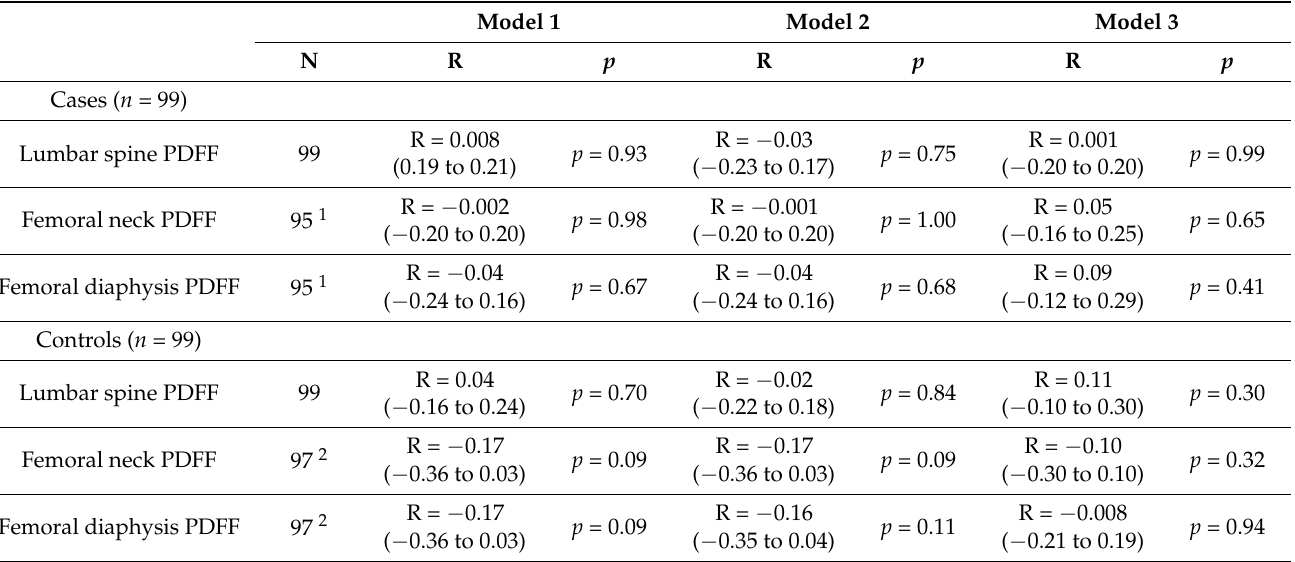
Table 3. Relationship between SOST and lumbar spine, femoral neck and femoral diaphysis PDFF. Model 1